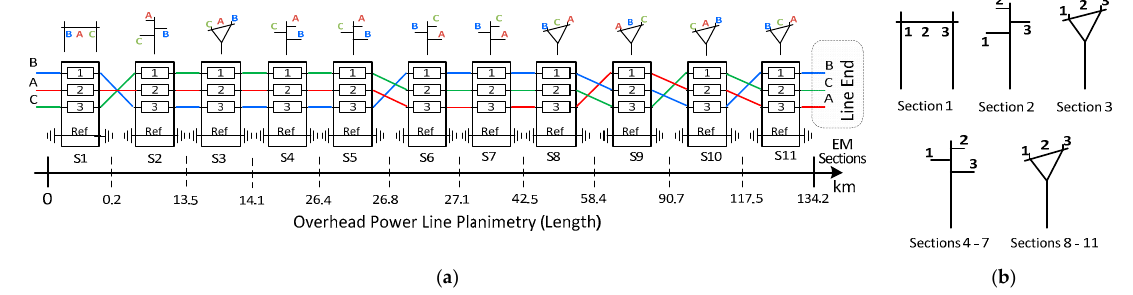
Figure 1. Electromagnetic modeling of the power line of interest: ( a ) Schematic of the equivalent line representation; ( b ) tower types found along the line for each section.